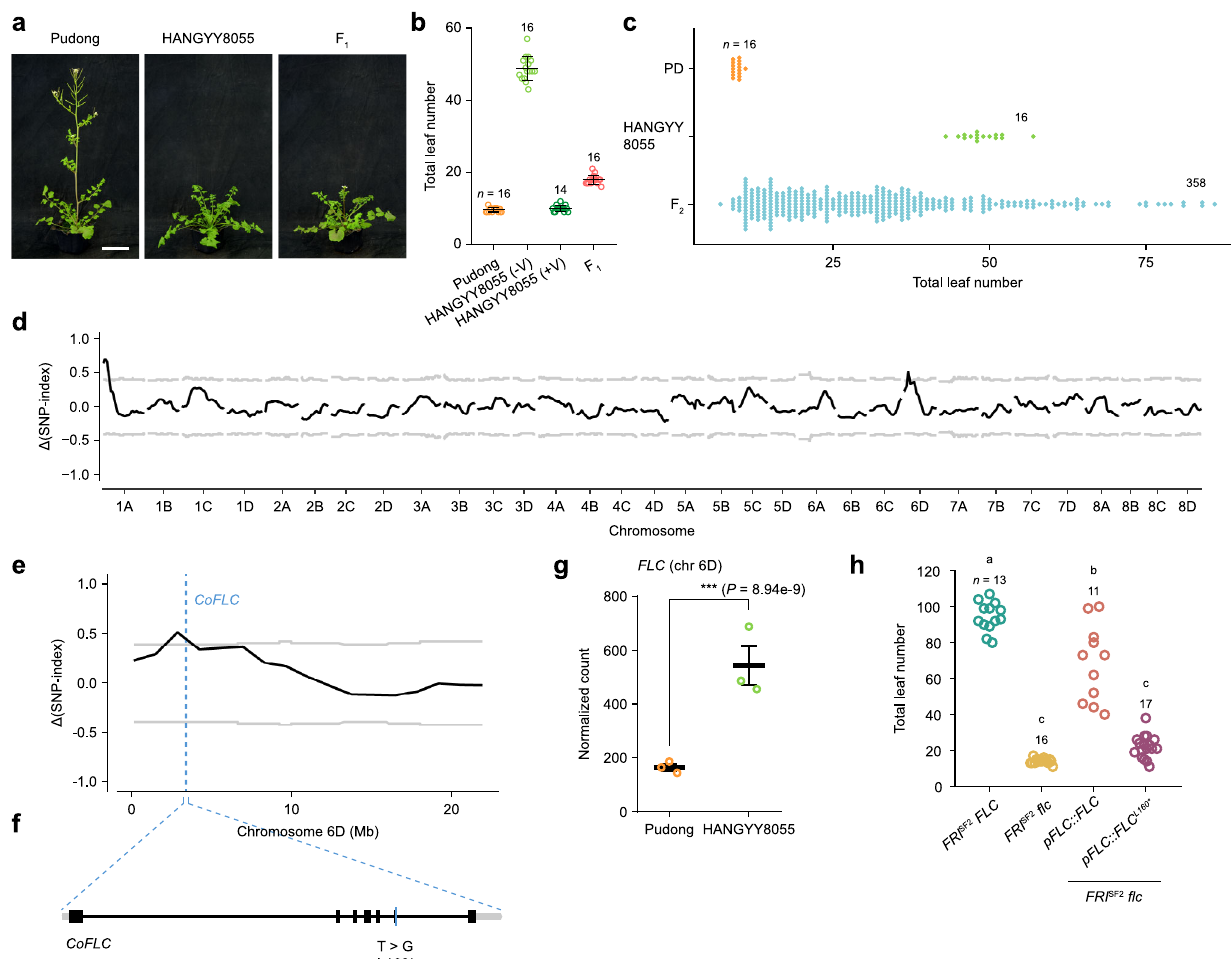
Fig. 3 | Identi fi cation of FLC as the gene responsible for the loss of the verna- lization requirement in pop3. a , b Flowering phenotypes ( a ) and fl owering time ( b ) of the Pudong and HANGYY8055 accessions and Pudong × HANGYY8055 F 1 plants grown in LD in a growth chamber. +/ − V, with or without vernalization treatment. Scalebar in( a ) 5cm. c Flowering time of the Pudong and HANGYY8055 accessions and plants in the Pudong × HANGYY8055 F 2 segregating population in LD. d Genome-wide Δ (SNP index) plot from BSA of the F 2 segregating population derived from a cross between Pudong and HANGYY8055. The black lines indicate tricube-smoothed Δ (SNP index), and gray lines represent the corresponding two- sided99% con fi denceintervals. e The Δ (SNP index)plotof Chr6D from BSA of the F 2 segregating population derived from a cross between Pudong and HANGYY8055. The black line indicates tricube-smoothed Δ (SNP index), and gray lines markthe corresponding two-sided99%con fi denceintervals. The blue dotted lineindicatesthelocationof C.occultaFLC ( CoFLC )onChr6D. f Thegenestructure